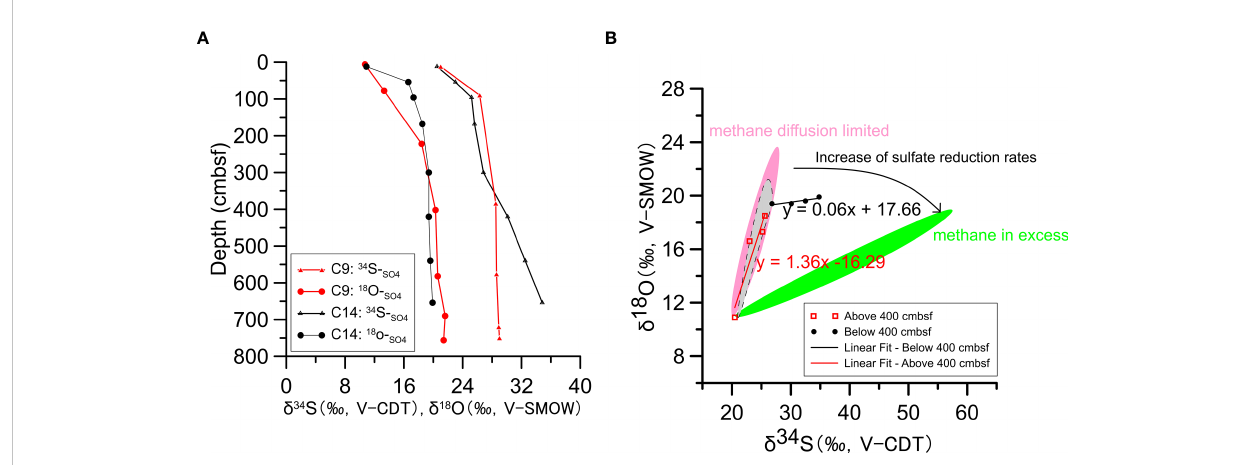
FIGURE 5 (A) S and O isotopic composition of sulfate in pore water at stations C9 and C14. (B) The d 18 O sulfate versus d 34 S sulfate data from pore water sulfate for studies sites. The lines represent the general increasing trends of pore water sulfate in a d 18 O sulfate versus d 34 S sulfate plot, which are based on the environmental pore water data. The pink and green shadows for “ methane diffusion limited ” and “ methane in excess ” environments, while the gray shadow for possible trend of d 18 O sulfate versus d 34 S sulfate at station